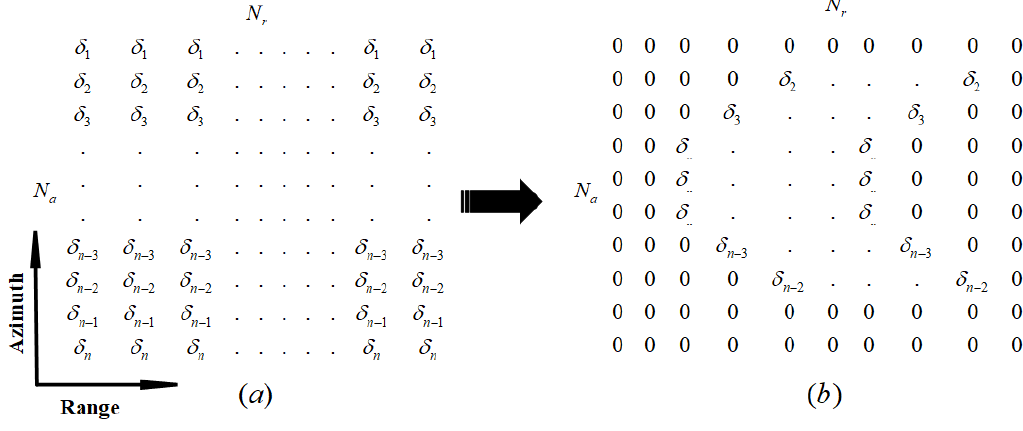
Figure 8. The k - th backscatter magnitude matrix of point target: ( a ) magnitude matrix before the envelope; ( b ) magnitude matrix after the envelope.